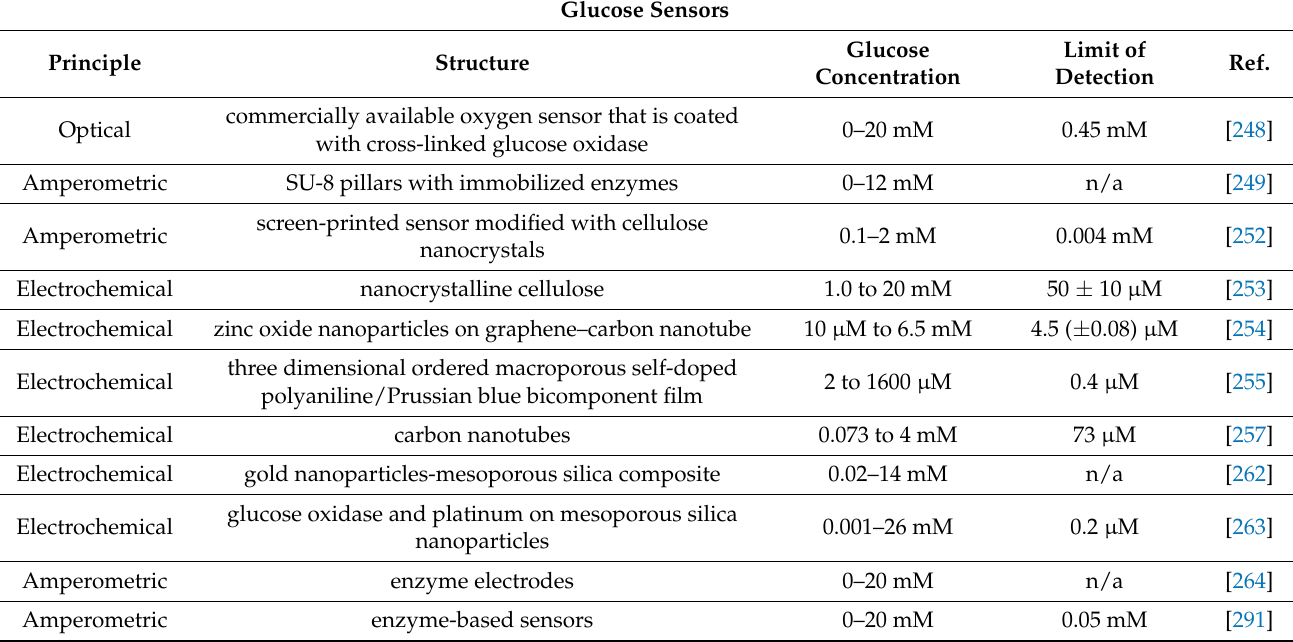
Table 7. Sensors for nutrients and metabolites used during cell